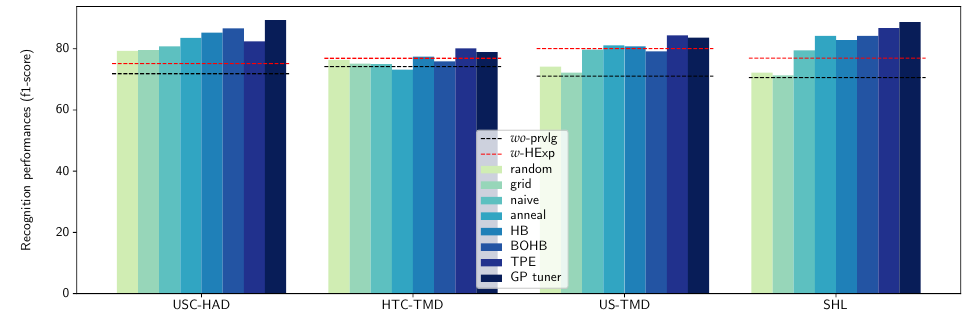
Figure 23. Impact of the architecture space exploration strategy used to derive privileged information incorporated into activity recognition models. Results obtained with the exploration strategies are listed in Section 6.2.1 are illustrated. Recognition performances, measured by the f1-score, of models trained with human expertise ( w -HExp) and without any privileged information ( wo -prvlg) are also